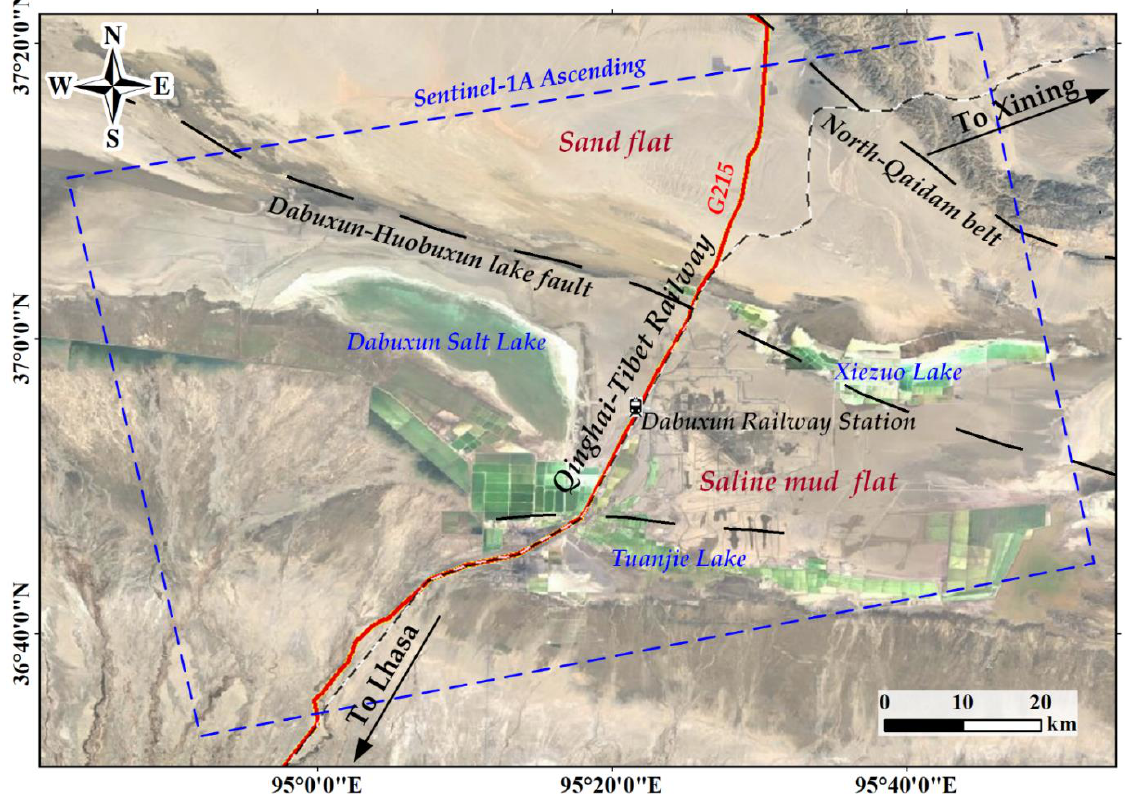
Figure 3. The geographical environment and transportation system in the study area, the black dotted lines indicate the faults, the sand flat and the saline mud flat in the blue dotted rectangle is the study area.